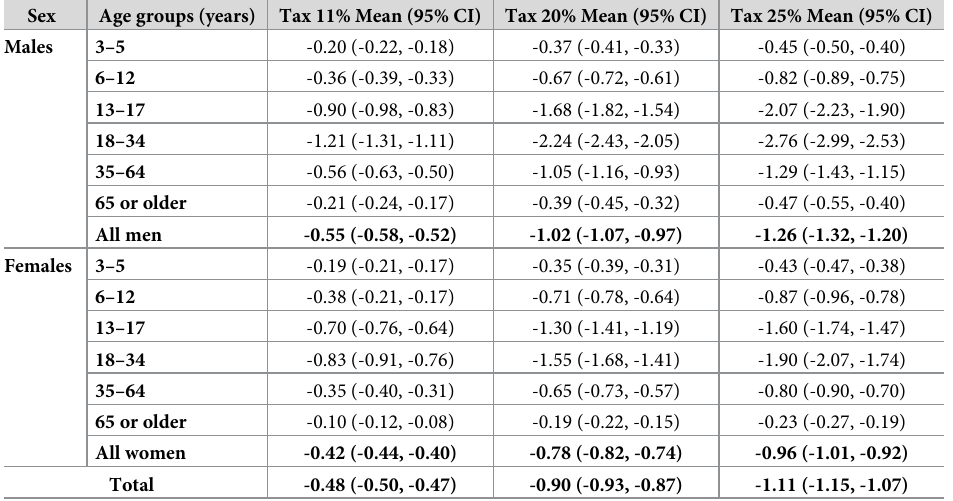
Table 3. Estimated change in weight (kg) after a 11%, 20% and 25% SSB tax by sex and age groups.